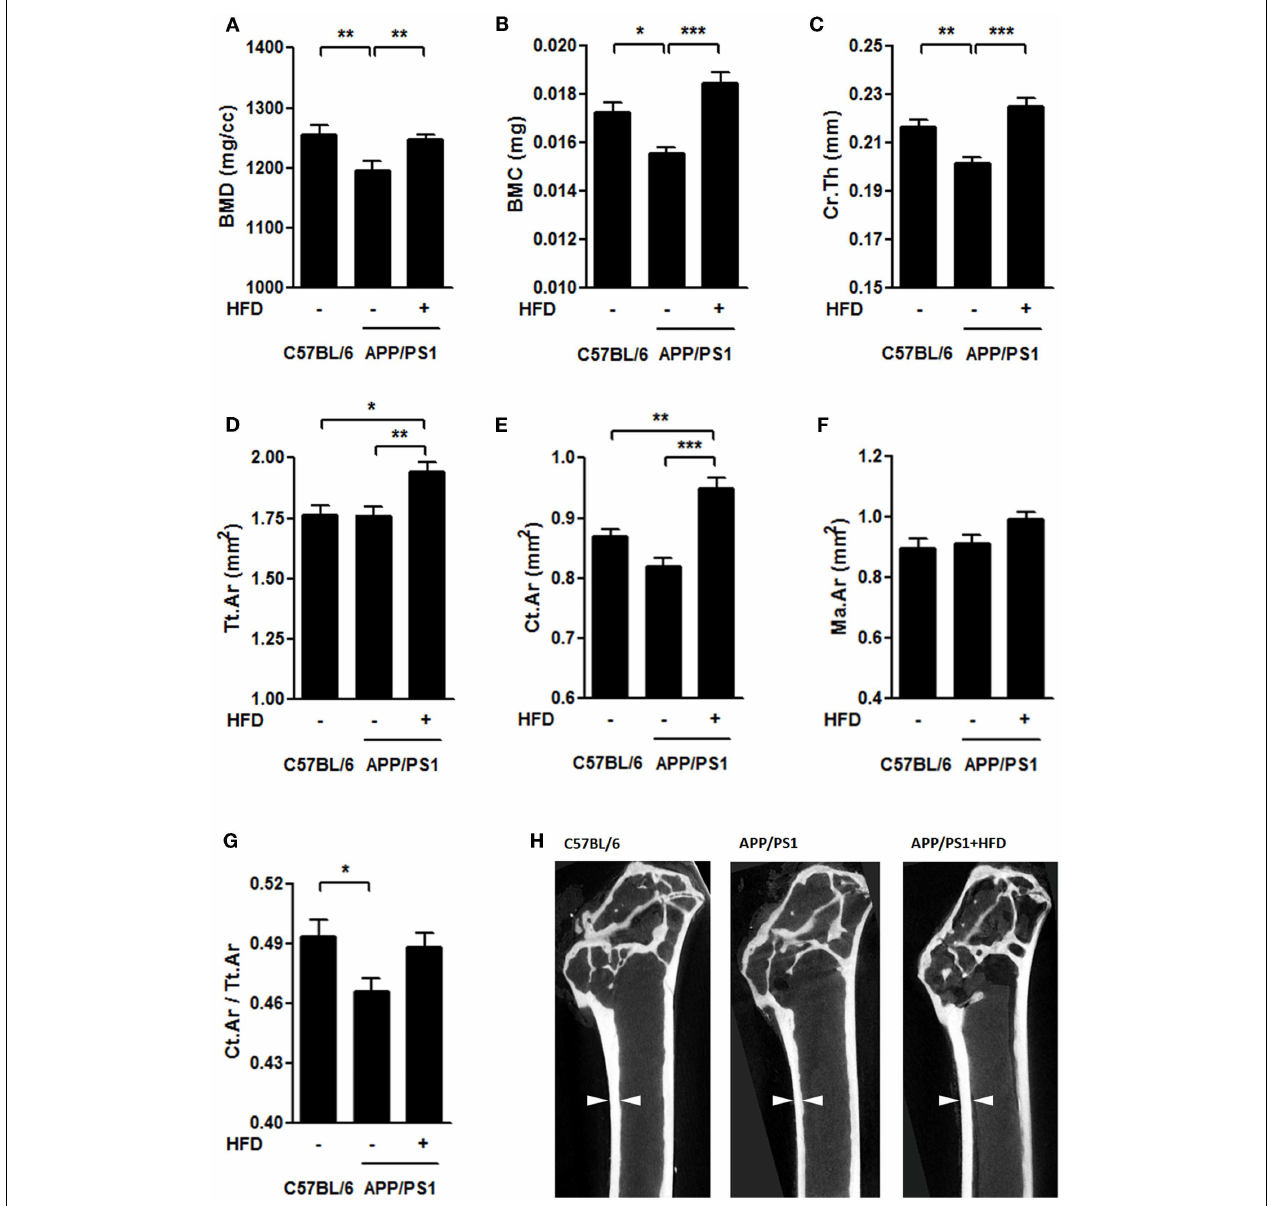
vary among the three groups (F) .The ratio of Ct.Ar toTt.Ar was decreased in APP/PS1 mice (G) , but not reversed by HFD feeding. Micrographs showed the differences of thickness and inner bone surface among all the groups with arrows indicating the representative part (H) . Data were means ± SEM. n = 7 for C57BL/6 mice, n = 8 for APP/PS1 mice, and n = 8 for APP/PS1 + HFD mice.The results were analyzed by one-way ANOVA, followed